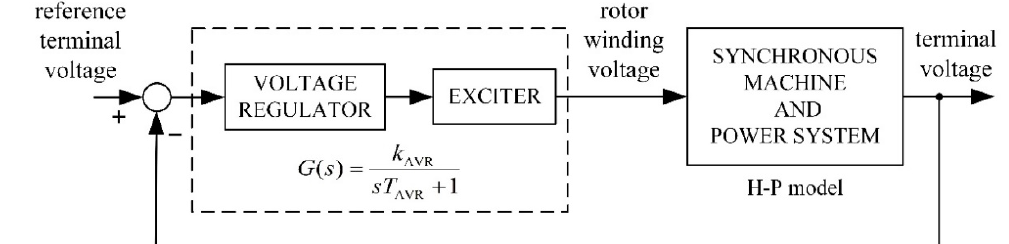
Figure 9. Block diagram of the studied AVR system.